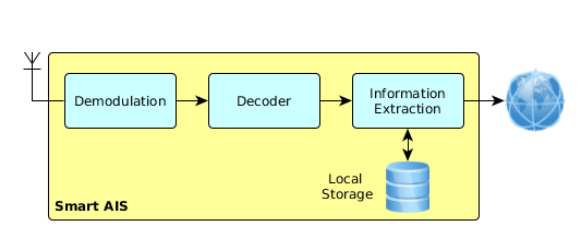
Figure 2. Basic flow of AIS messages from RF to retransmission.